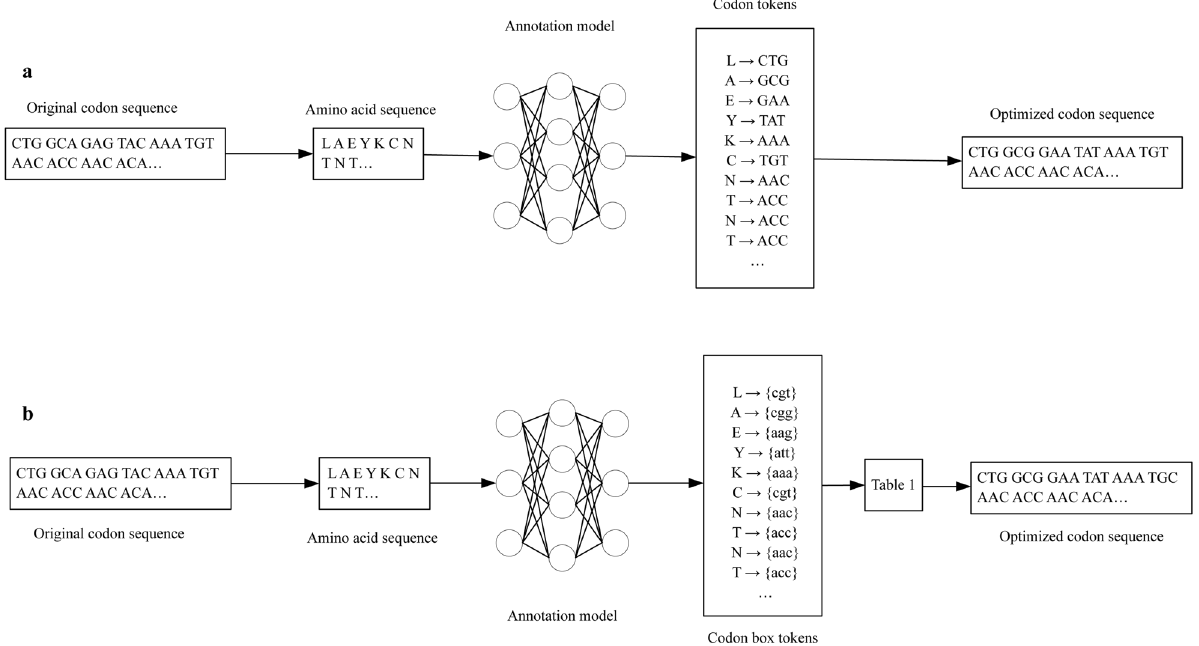
Figure 2. Codon optimization flowcharts based on sequence annotation models. First, the original codon sequences are decoded into amino acid sequences. Then, they are annotated by the trained sequence annotation models. In the flowchart in ( a ), the amino acid sequence is annotated with 61 kinds of codons, except stop codons (named BiLSTM-CRF(a)), and in the flowchart in ( b ), the amino acid sequence is annotated with 20 kinds of codon boxes (named BiLSTM-CRF(b)). The difference in ( b ) is that the optimized codons are determined from the codon boxes in Table 1 due to the one-to-one mapping of amino acids and codon boxes with codons mentioned in the previous section. Generally, the annotation model with fewer tokens is better, and the complexity of BiLSTM-CRF(b) is lower than that of BiLSTM-CRF(a).